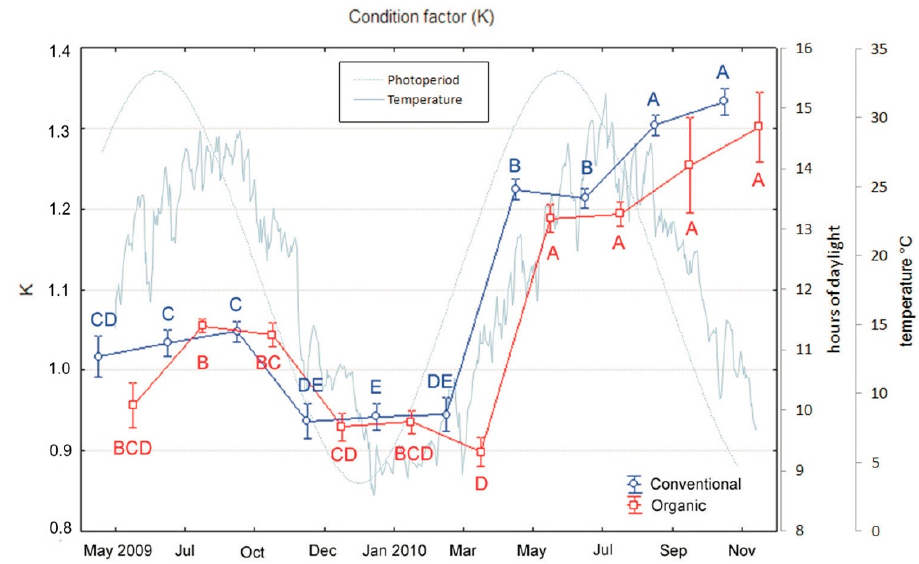
Figure 3. Variations in condition factor (K) of sea bass over an 18-month period (mean ± SE) reared under conventional and organic aquaculture. Different letters indicate significant differences in samplings within the same feeding system (organic or conventional; p < 0.05).